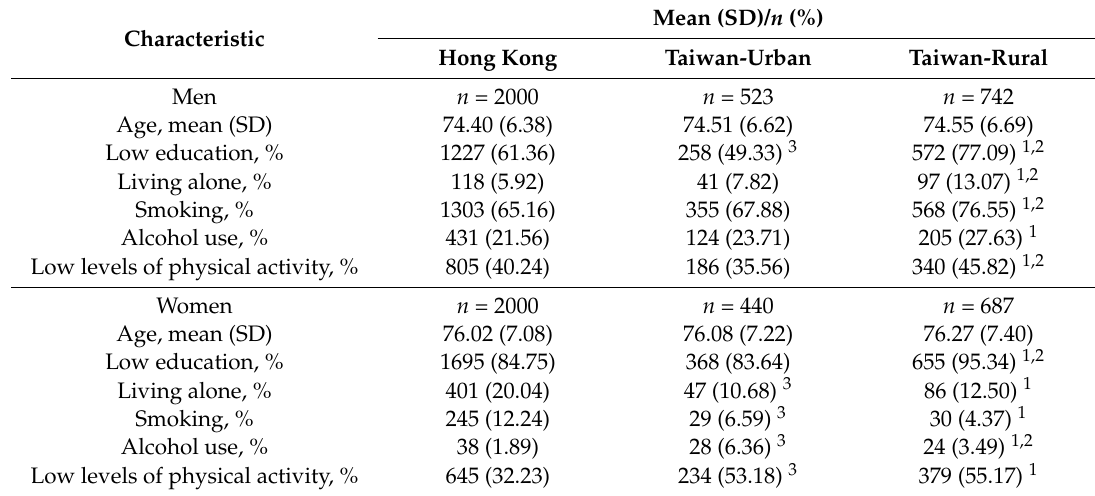
Table 2. Population characteristics between Hong Kong, Taiwan-urban and Taiwan-rural by sex. Mean (SD)/ n (%) Characteristic Hong Kong Taiwan-Urban